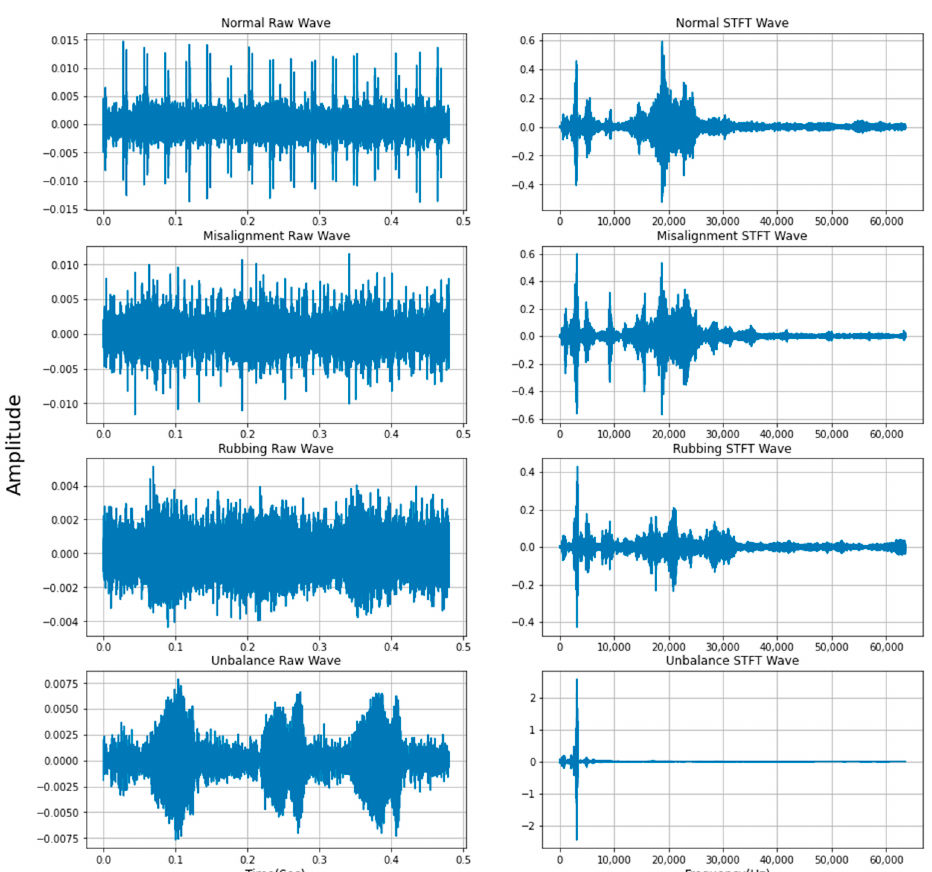
Figure 5. Original signals of each target class: Normal, Misalignment, Rubbing, and Unbalance ( Left ); Examples of Short-Time Fourier Transform (STFT) conversion of Normal, Misalignment, Rubbing, and Unbalance raw signals ( Right ).